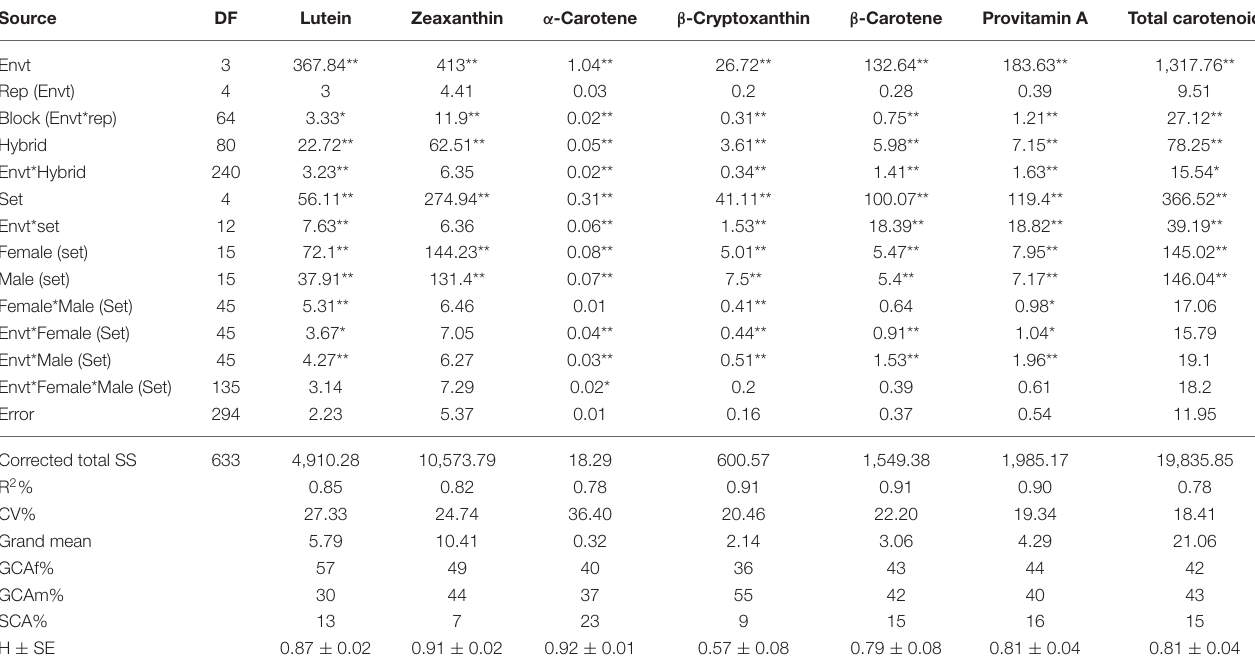
TABLE 1 | Summary mean squares of combined ANOVA across environments for carotenoid contents of 80 maize F1 hybrids involving 24 inbred lines plus one commercial hybrid